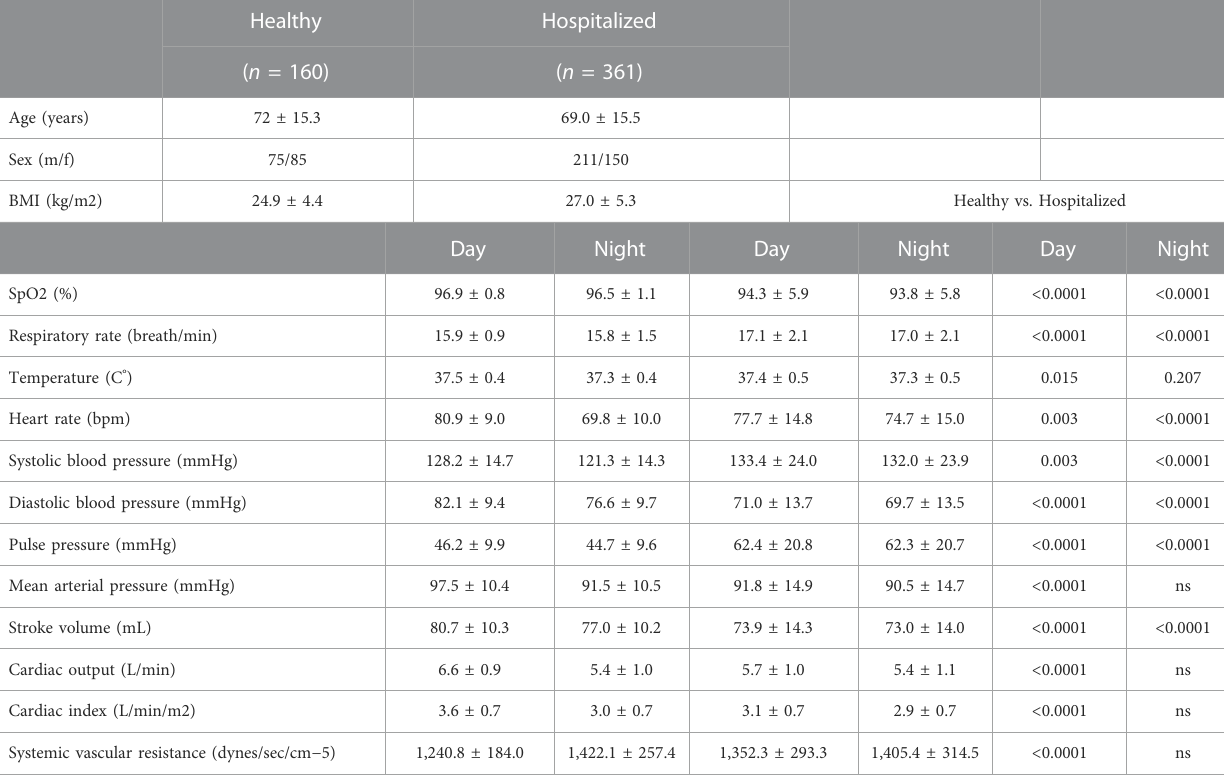
TABLE 1 Demographic data of the participants. BMI, body mass index; SPO2, blood oxygen saturation. ns, not signi fi